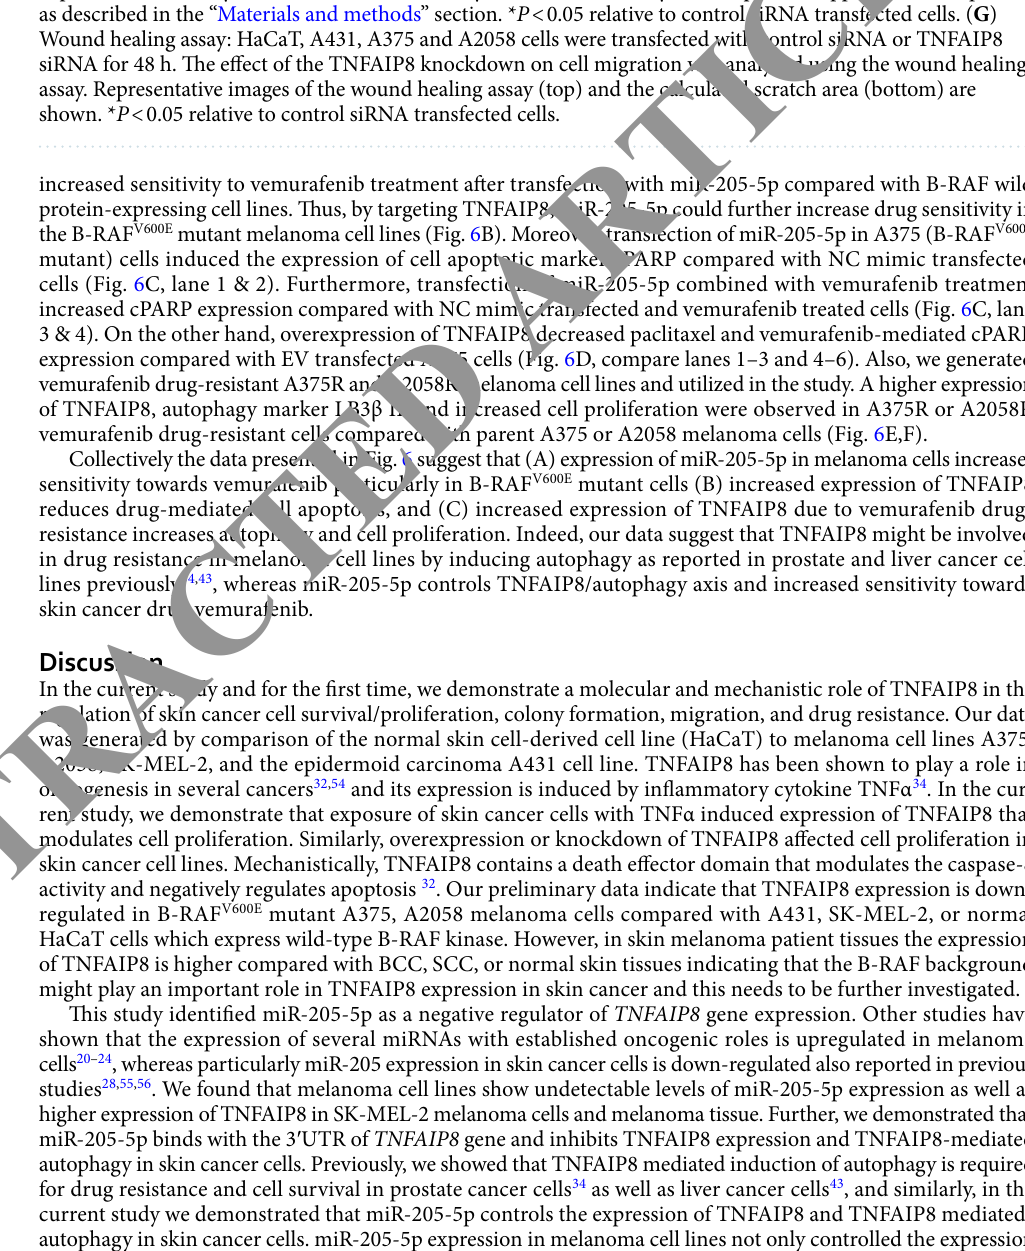
Figure 3. TNFAIP8 regulates cell proliferation and migration in skin cancer cells. ( A ) Western blotting analysis of TNFAIP8-Myc tagged protein expression in HaCaT and skin cancer cells. Immunoreactive bands were developed using ECL chemiluminescence detection reagents and the blots were scanned using an Odyssey CLx imager. The immunoblot scans were converted into grayscale and presented. (B) Effect of TNFAIP8-Myc protein overexpression on HaCaT, A431, A375 and, A2058 on cell survival was measured by MTT assay. Results are representative of three independent experiments. * P < 0.05 relative to EV transfected cells. ( C ) The effect of overexpression of TNFAIP8-Myc on cell colony formation was analyzed and plotted (upper and lower panels) as described in the “Materials and methods” section. * P < 0.05 relative to EV transfected cells. ( D ) HaCaT, A431, A375 and, A2058 cells were transfected with control siRNA or TNFAIP8 siRNA (100 nM) for 30 h, and cell lysates were western blotted with anti-TNFAIP8 and β-actin antibodies. Western blots were developed using ECL chemiluminescence detection reagents and the blots were scanned using an Odyssey CLx imager. The immunoblot scans were converted into grayscale and presented. TNFAIP8 and β-actin protein levels were quantified using ImageJ software (https:// imagej. nih. gov/ ij/) and presented below. ( E ) The effect of TNFAIP8 knockdown by siRNA on cell survival was analyzed by MTT assay. The experiments were independently performed three times. * P < 0.05 relative to control siRNA transfected cells. ( F ) Control siRNA and TNFAIP8 siRNA-transfected HaCaT, A431, A375 and A2058 cells (3000 cells/well) were re-plated in 6-well plates in triplicate for 7–10 days and skin cancer cell colony formation was analyzed and plotted (upper and lower panels) as described in the “Materials and methods” section. * P < 0.05 relative to control siRNA transfected cells. ( G